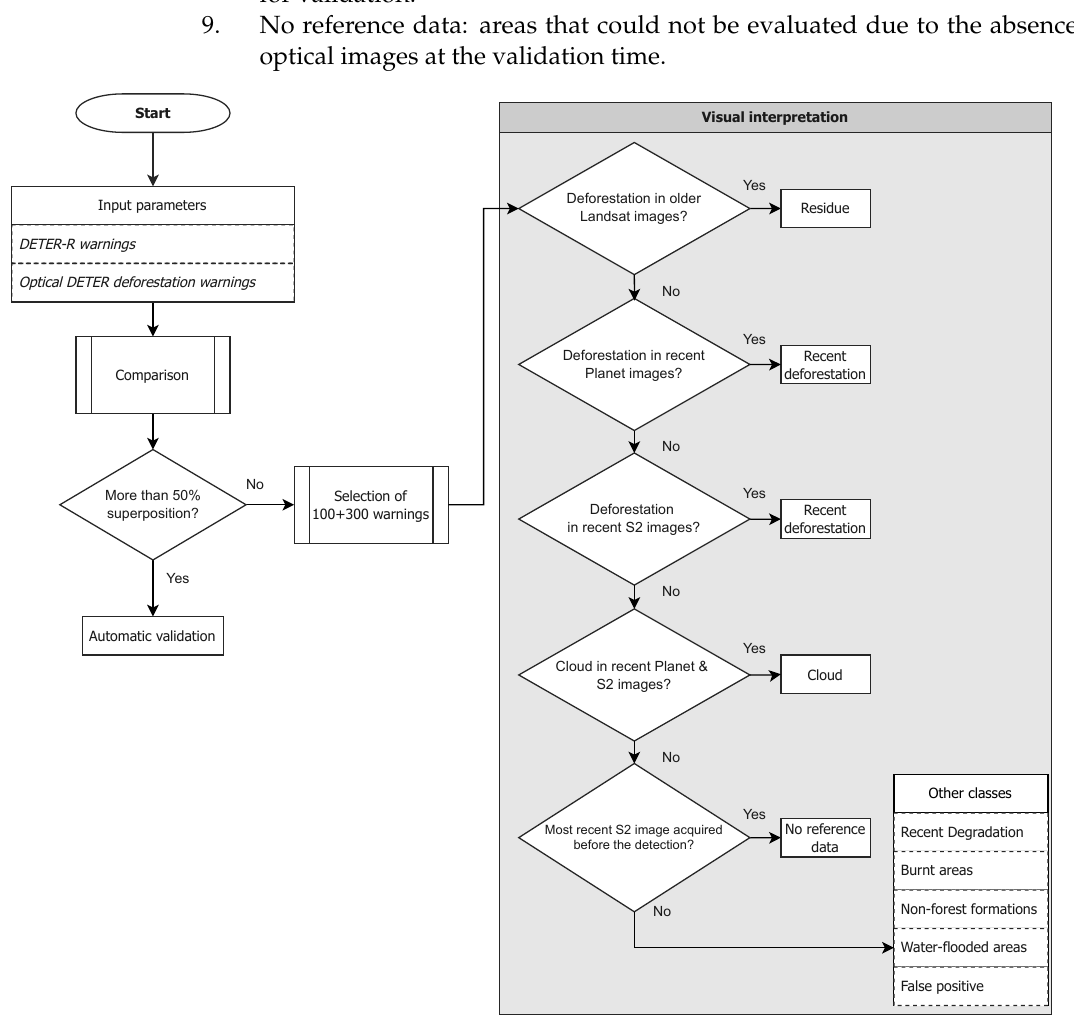
Figure 7. Flowchart of validation